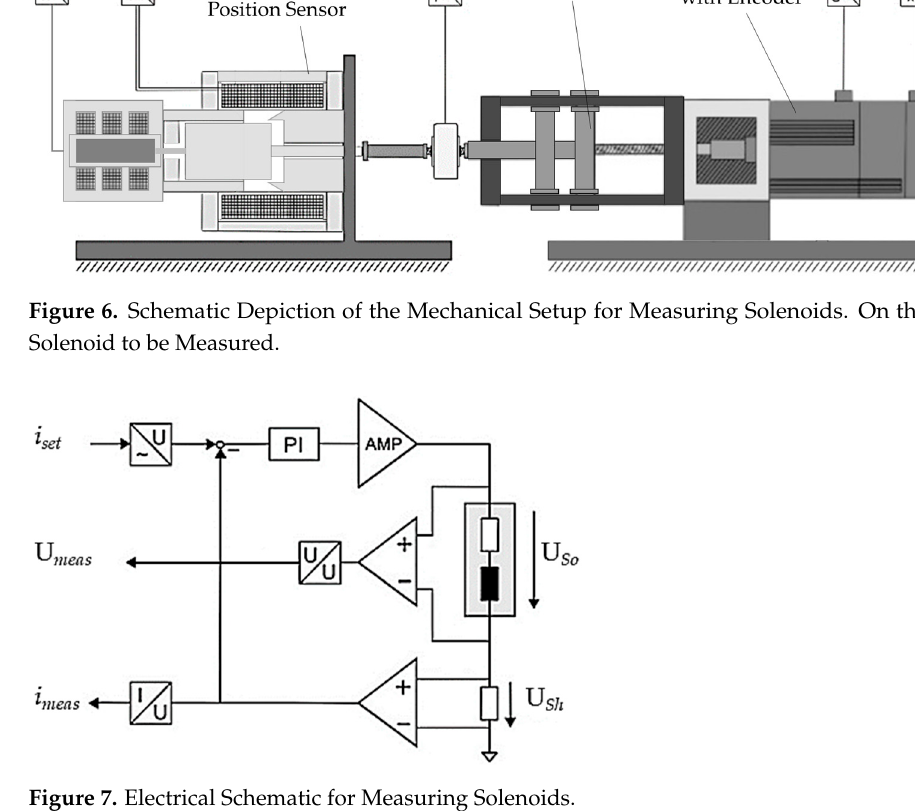
Figure 7. Electrical Schematic for Measuring Solenoids.